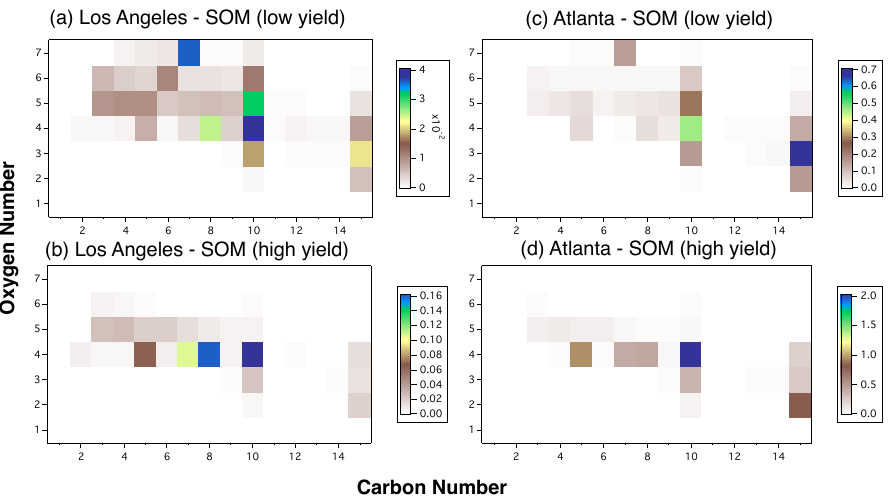
Figure 5. Predicted distribution of the SOA mass (in µgm − 3 ) in carbon and oxygen space for Los Angeles (a, b) , and Atlanta (c, d) from the SOM (low yield) and SOM (high yield) simulations. Note the different color scales.